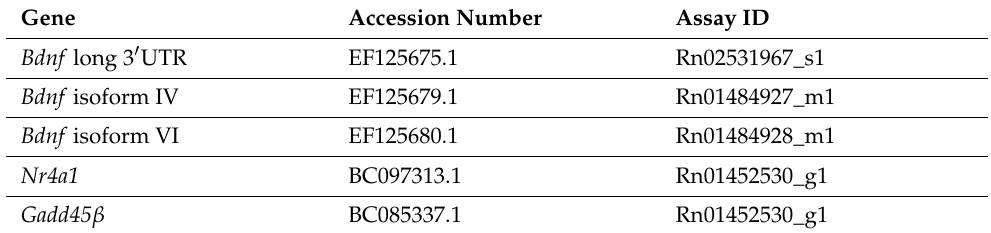
Table 2. Primers and probes sequences acquired from Life